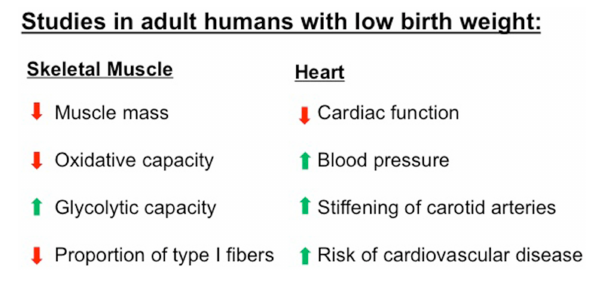
FIGURE 2 | Numerous studies have demonstrated that adult humans who were born with low birth weight have abnormalities in characteristics of skeletal muscle and heart, two tissues that have high metabolic demands. These abnormalities increase the risk for metabolic diseases including obesity, type 2 diabetes, and cardiovascular diseases. Please refer to text for specific